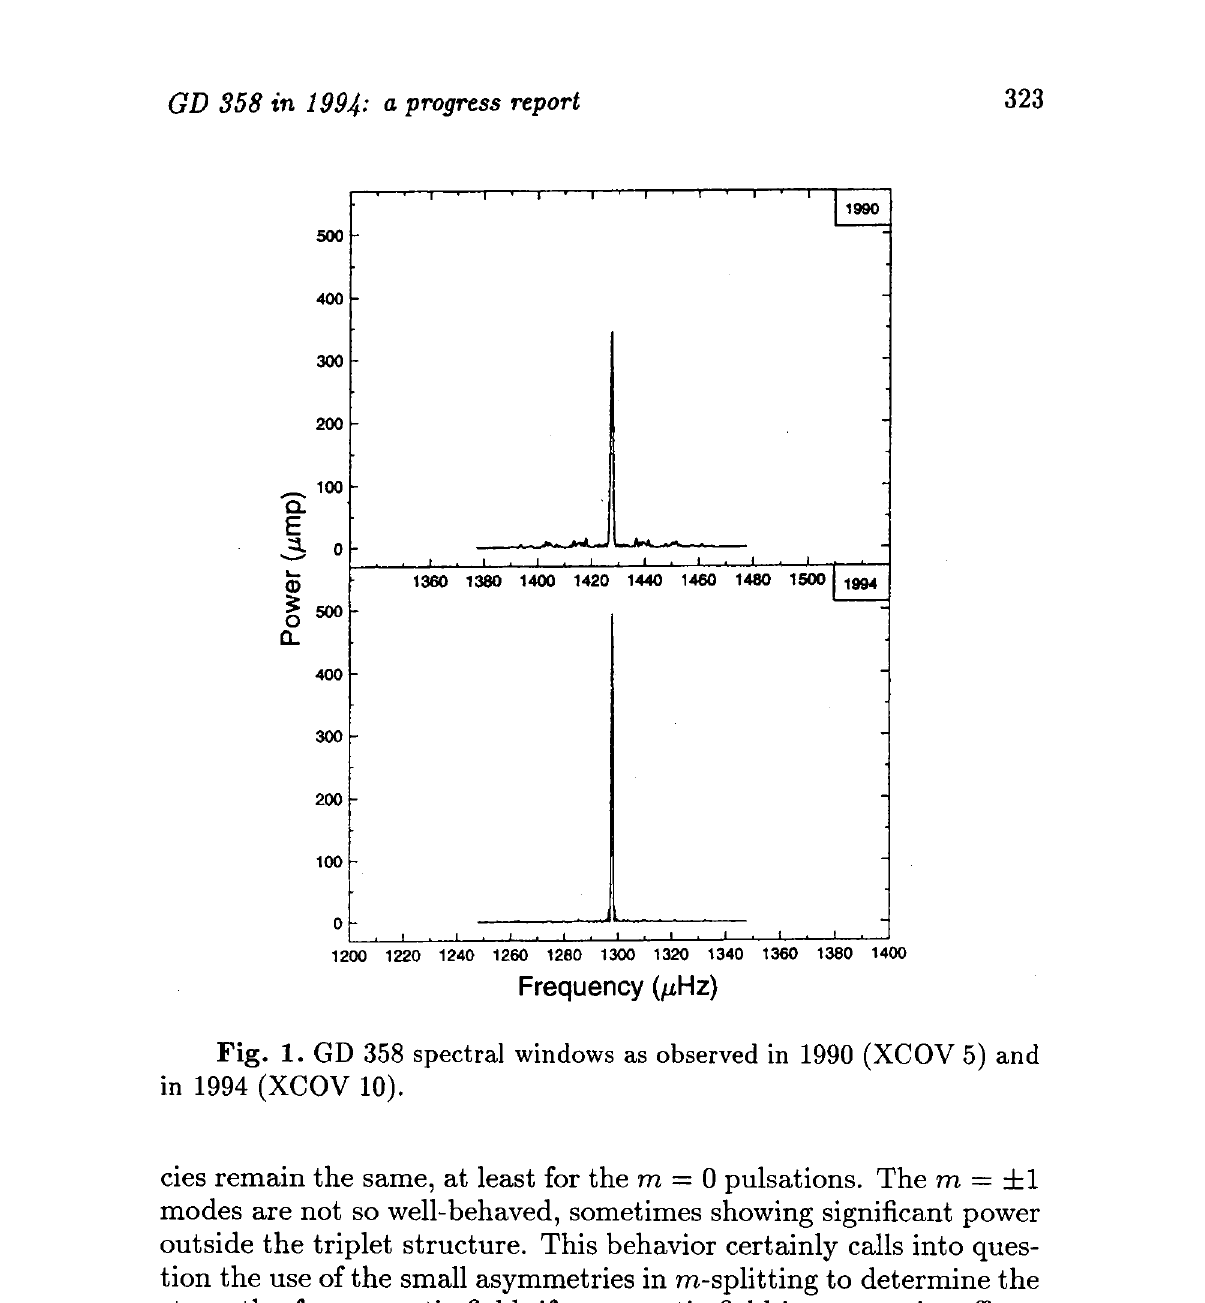
Fig. 1. GD 358 spectral windows as observed in 1990 (XCOV 5) and in 1994 (XCOV